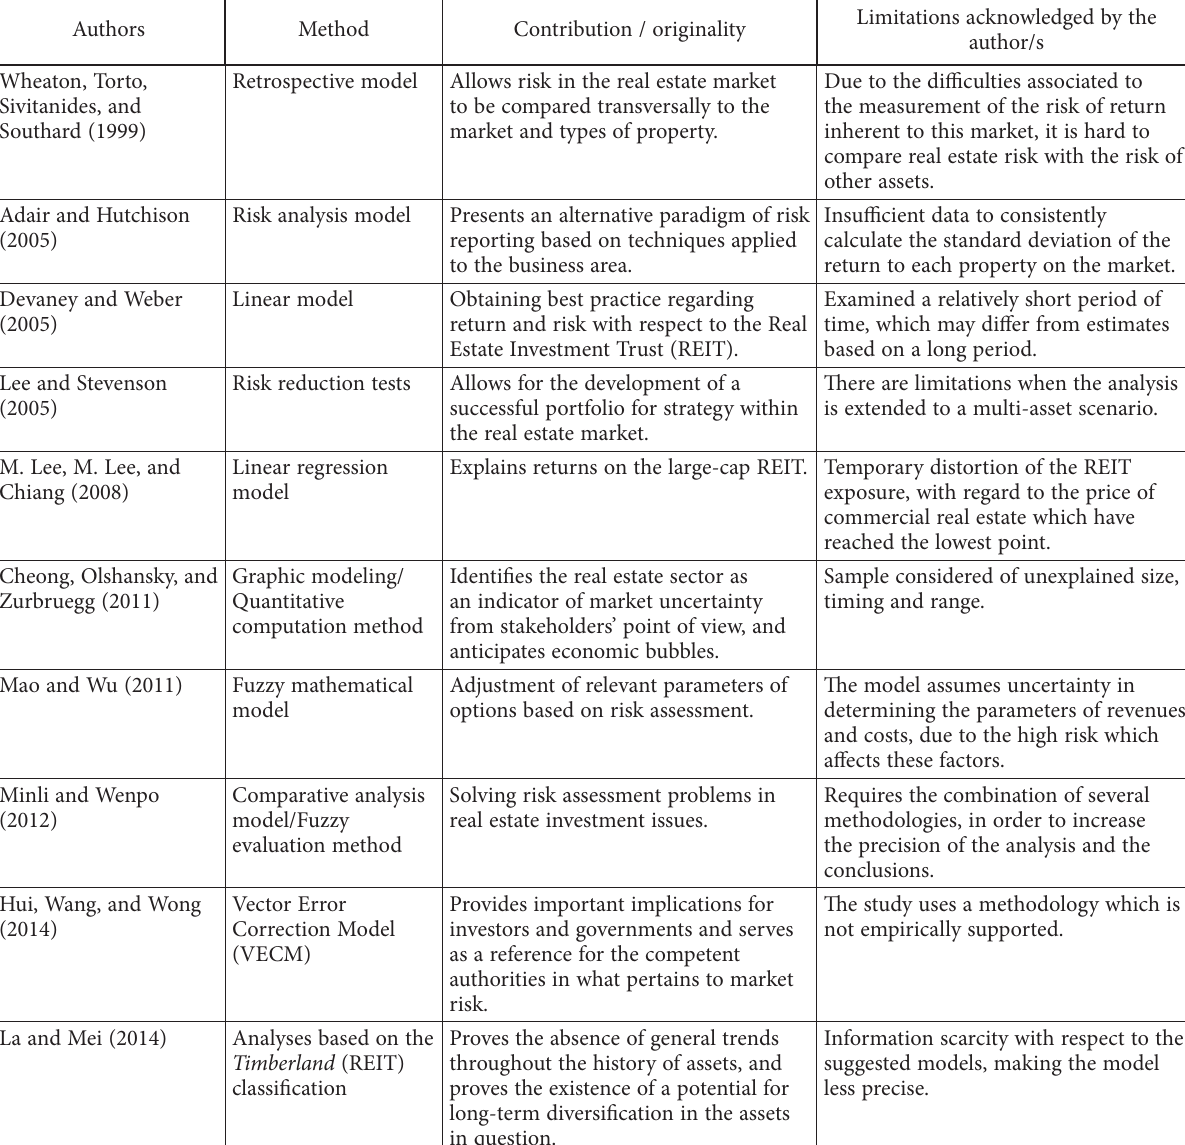
Table 1. Contributions regarding real estate investment risk